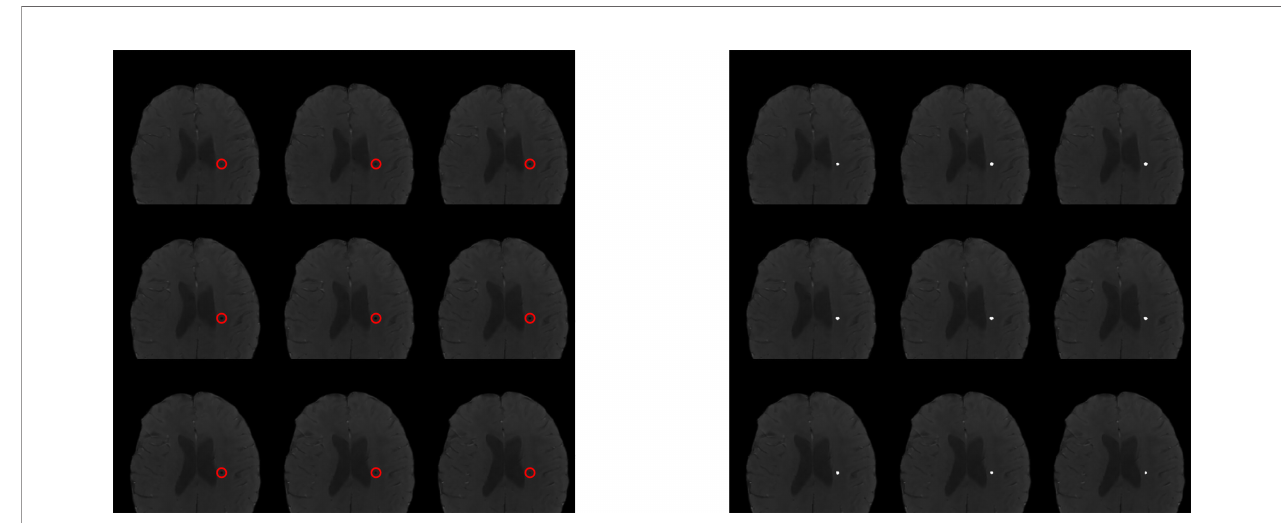
FIGURE 2 | Visual representation of CMB analysis. Imaging inclusive of semi-automated lesion segmentation iron-sensitive sequence analysis. Left panel shows sequence without segmentation label with manually insertion of red circle outlining area of known cerebral microbleed. Right panel displays with semi-automated insertion of white circle overlying area of cerebral microbleed identi fi ed on segmentation.